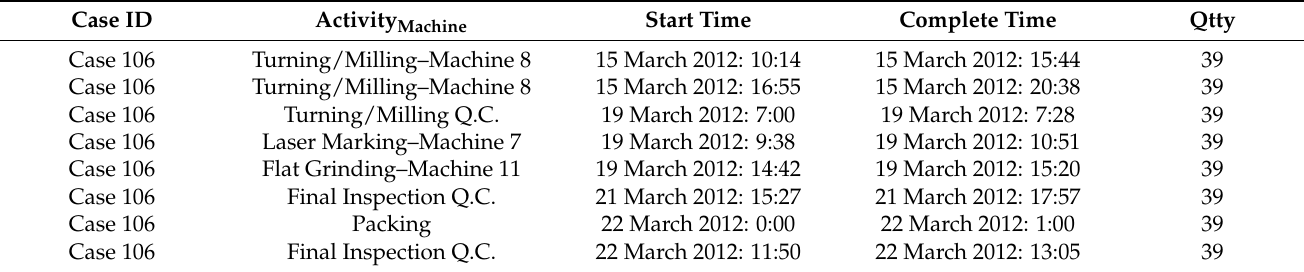
Table 5. Industrial event log of Case